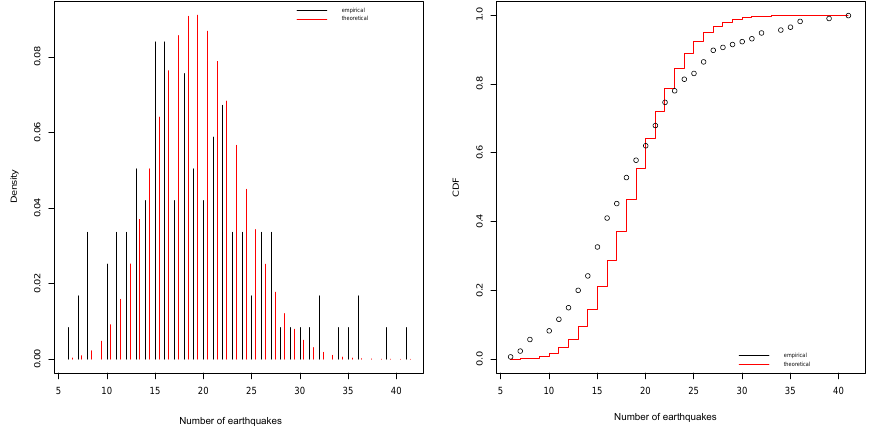
Figure 8 – Fitted Poisson distribution for earthquake